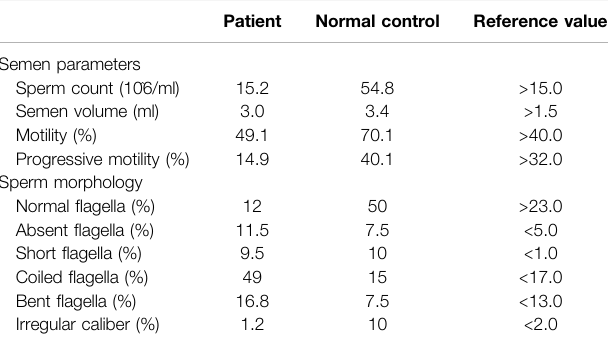
TABLE3| Semenparametersandsperm fl agellamorphologyinpatient1carrying RSPH4A variants.